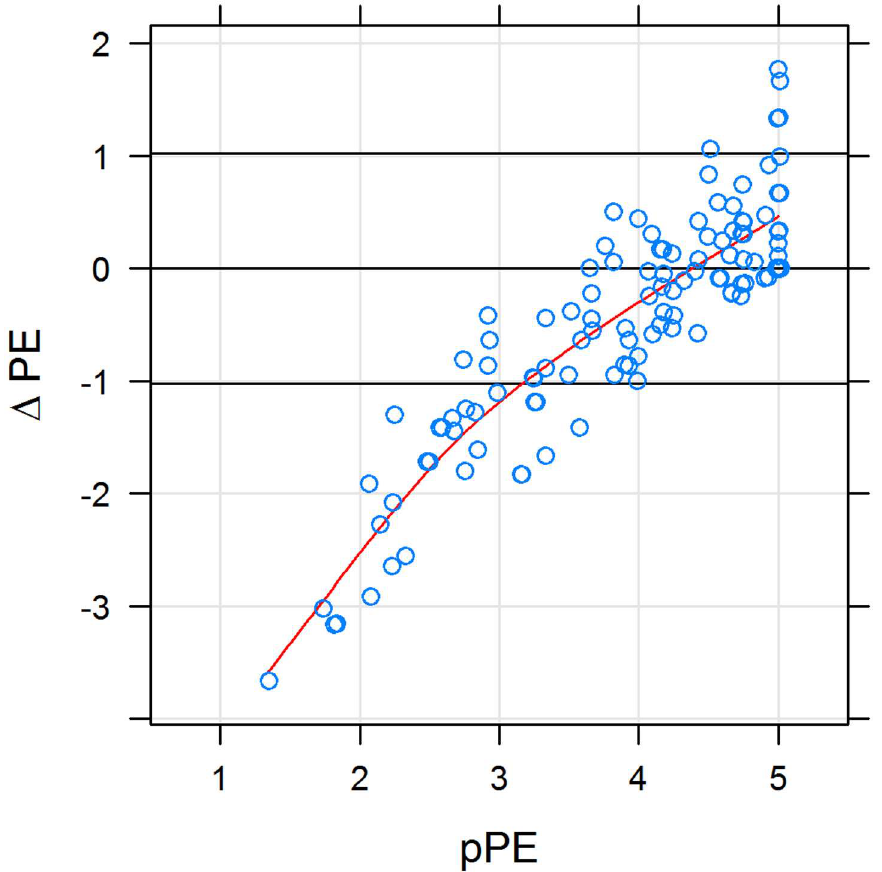
Fig 4. Differencebetween desired and perceivedphysician empathy ( Δ PE) as a function of perceived physician empathy (pPE). X-Y scatterplot; horizontallines denoteequality betweendesired and perceived physicianempathy plus or minus 1 standarddeviation. Red curve is a cubic spline fit. Perceivedphysician empathy and Δ PE were strongly correlated(Spearman’s rho = 0.83; p < 10 − 15 ). Desiredand perceived physicianempathy were balancedif perceivedphysicianempathy was > 4. In 28 subjects, Δ PE was 1 SD belowzero, and in 5 cases it was 1 SD above.